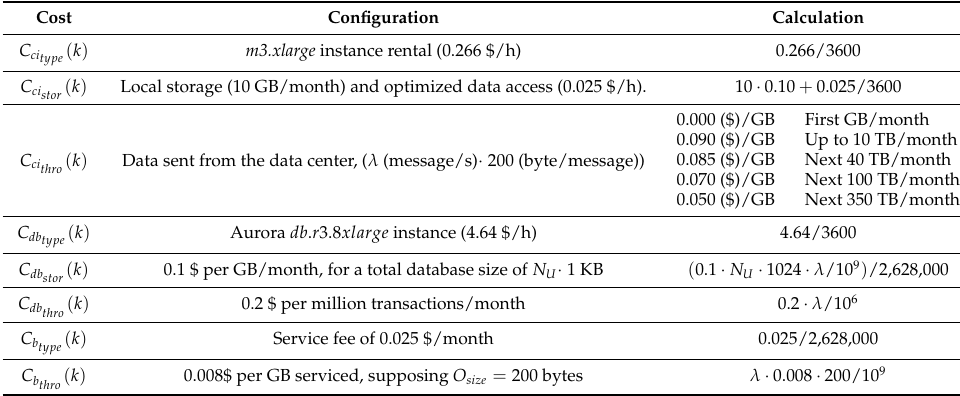
Table 5. Cloud service configuration and cost